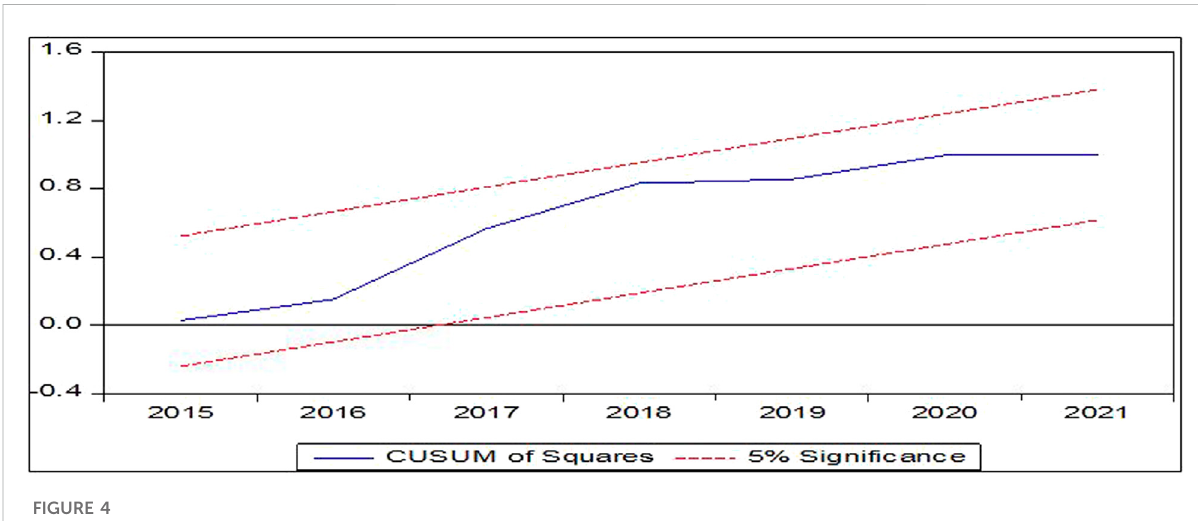
FIGURE 4 CUSUM square